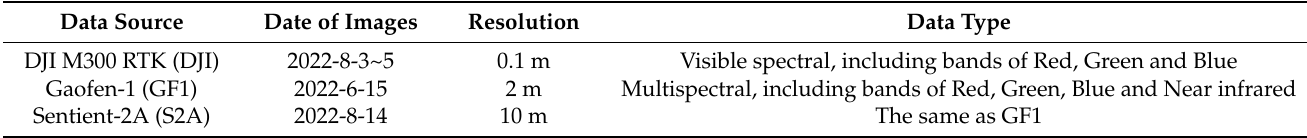
Table 1. Details of the data used in the study.